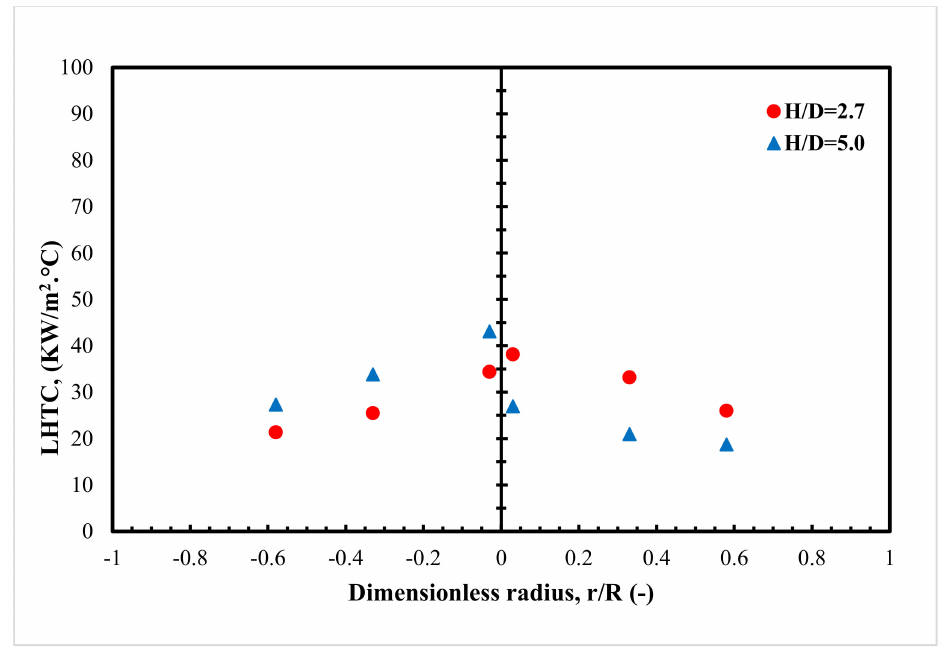
Figure 13. LHTC profiles measured at the different axial levels of 35 and 70 cm and under an operating gas velocity of 0.15